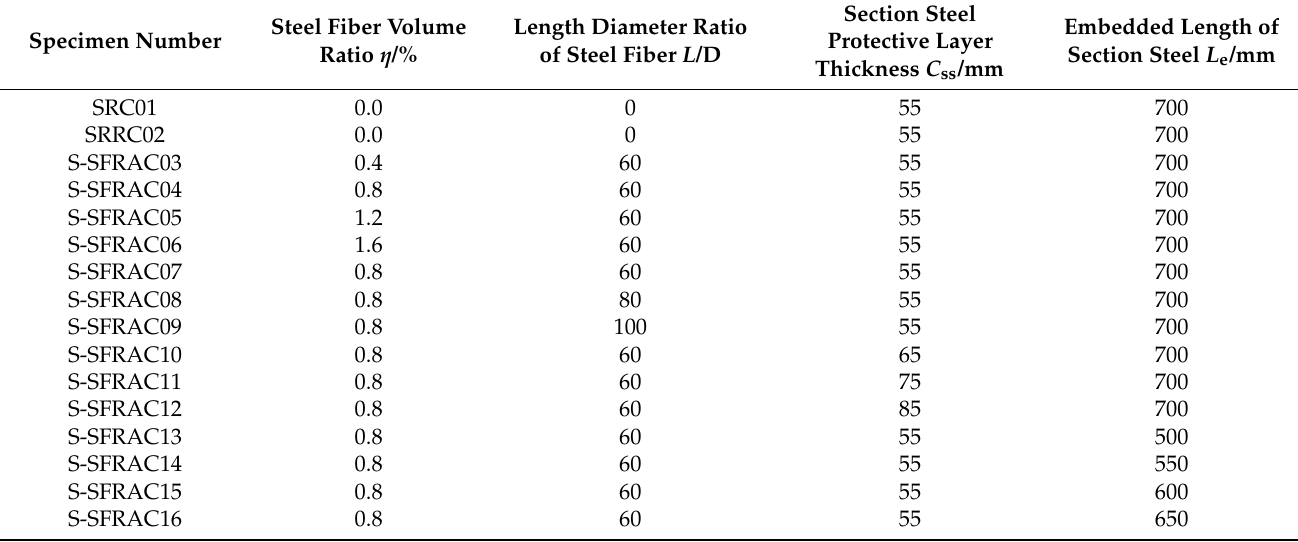
Table 5. Detailed design parameters of the specimens.